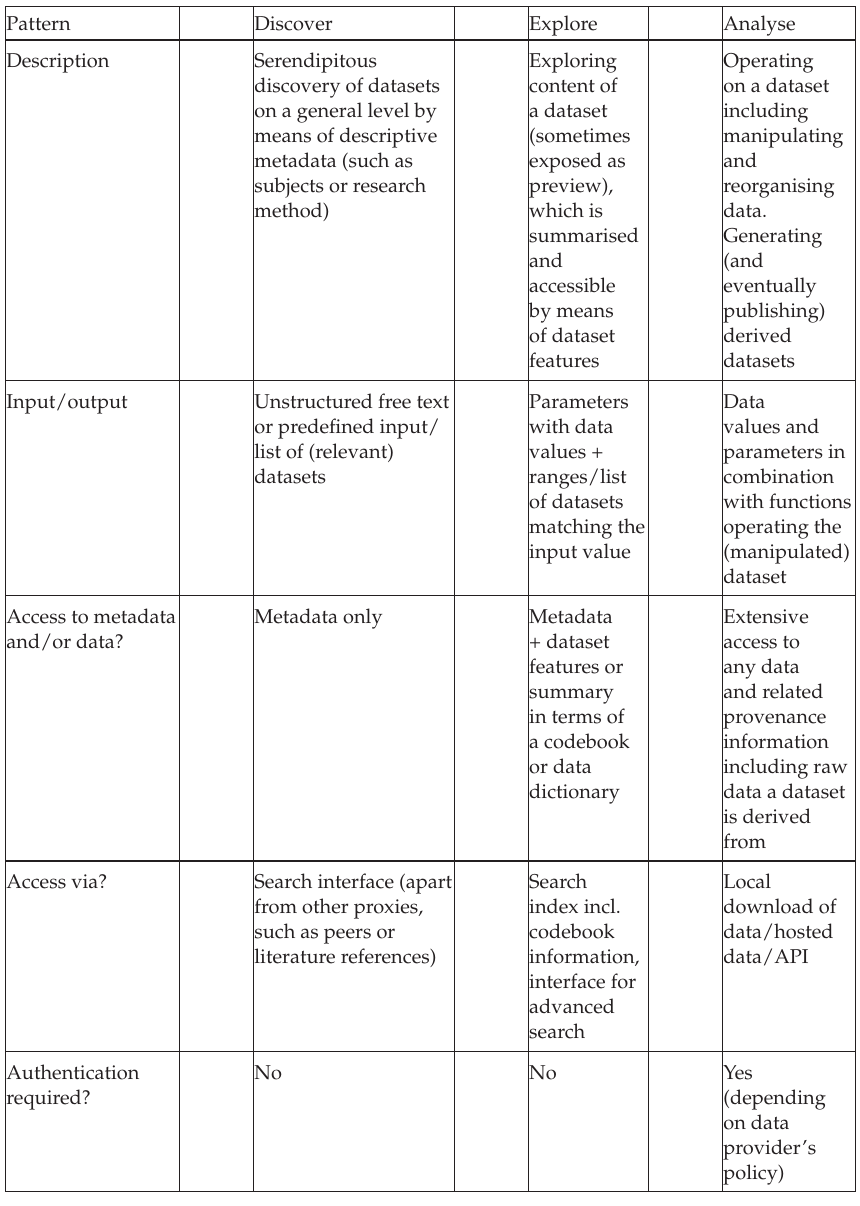
Table 1: Patterns of data